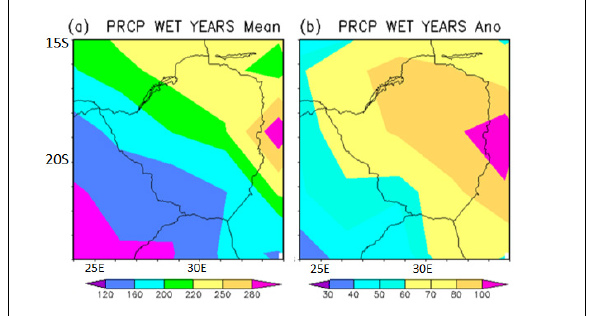
(a) Rainfall composite mean and (b) rainfall anomaly maps for Zimbabwe for the November to January season (in mm) from 1980 to 2013.